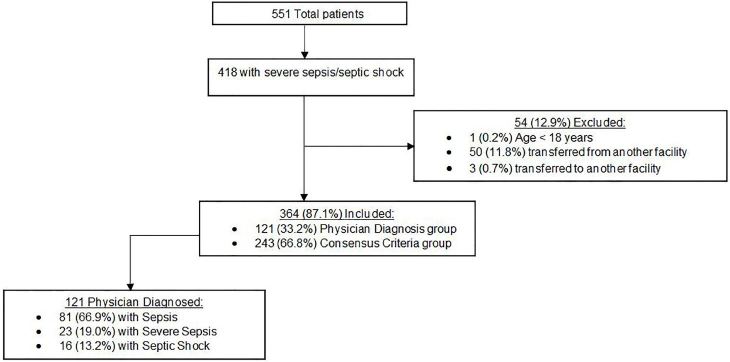
Study flow diagram of the total number of patients in this study of sepsis-related diagnosis, including the number of included and excluded patients.